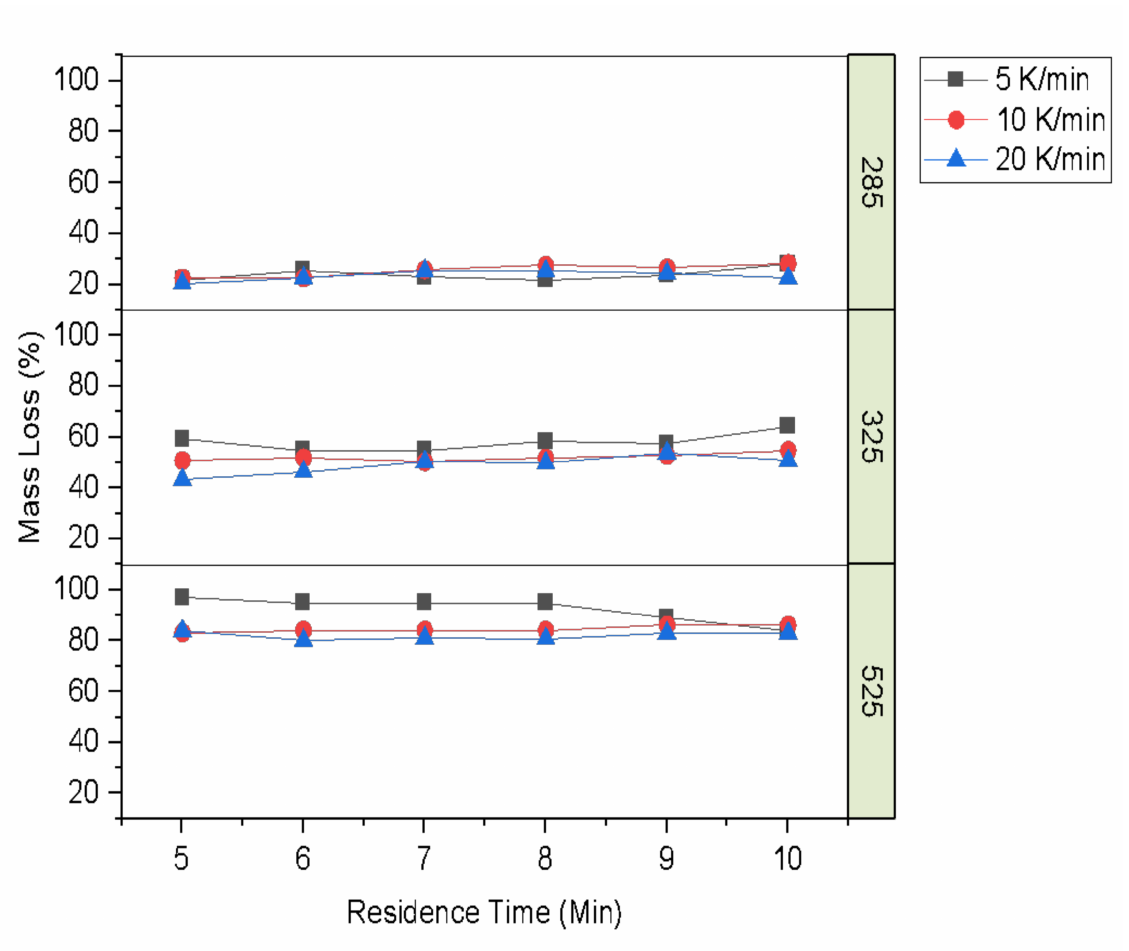
Figure 6. Mass losses during thermogravimetric analysis of pine